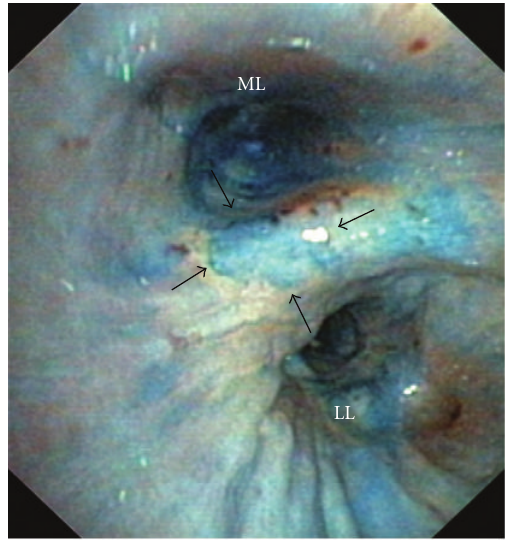
Figure 2: Circumscribed staining (arrows) in chromobron- choscopy; ML: middle lobe, LL: lower lobe; histology showed unspecific